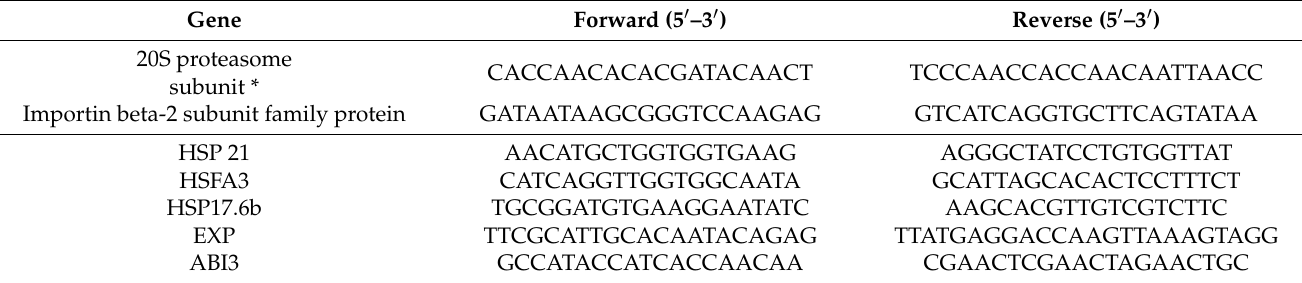
Table 5. Primer sequences used as target and reference genes (mRNAs) in the RT qPCR reactions. Gene Forward (5 (cid:48) –3 (cid:48) ) Reverse (5 (cid:48) –3 (cid:48)